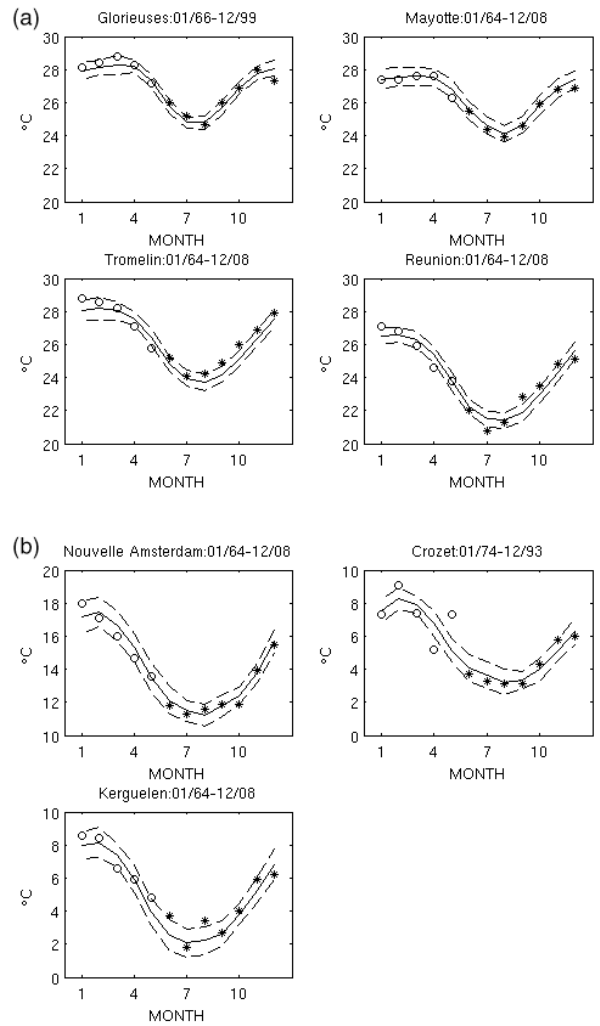
Figure 5. Comparison of climatological mean precipitation in the different islands and monthly mean precipitation following the Mount Pinatubo eruption from June to December 1991 (stars) and from January to May 1992 (circles) (a) for the lower-latitude islands (Glorieuses, Mayotte, Tromelin, Réunion) and (b) for the higher- latitude islands (Nouvelle Amsterdam, Crozet Islands, Kerguelen Islands). The solid and dashed lines show the mean values and the SD, respectively.